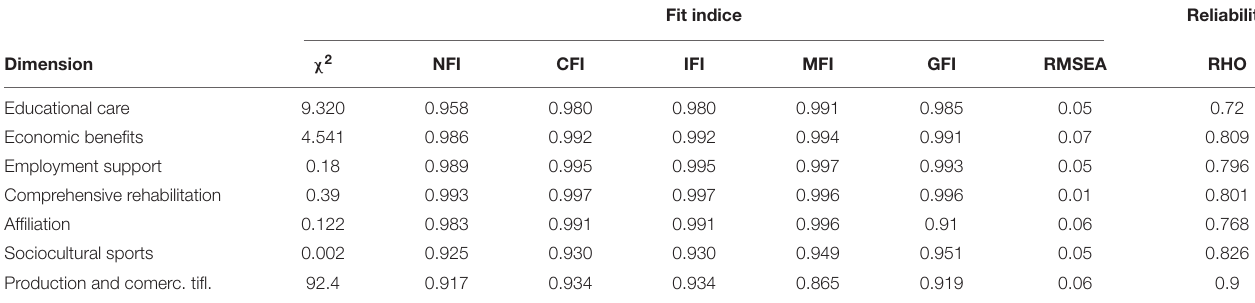
TABLE 5 | Fitting the each dimension models in the first order FCA.